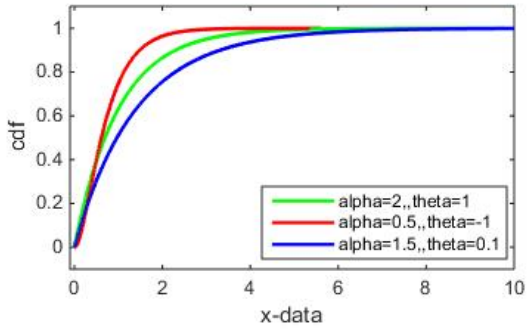
Fig. 2. Plot the cdf of (TE) distribution